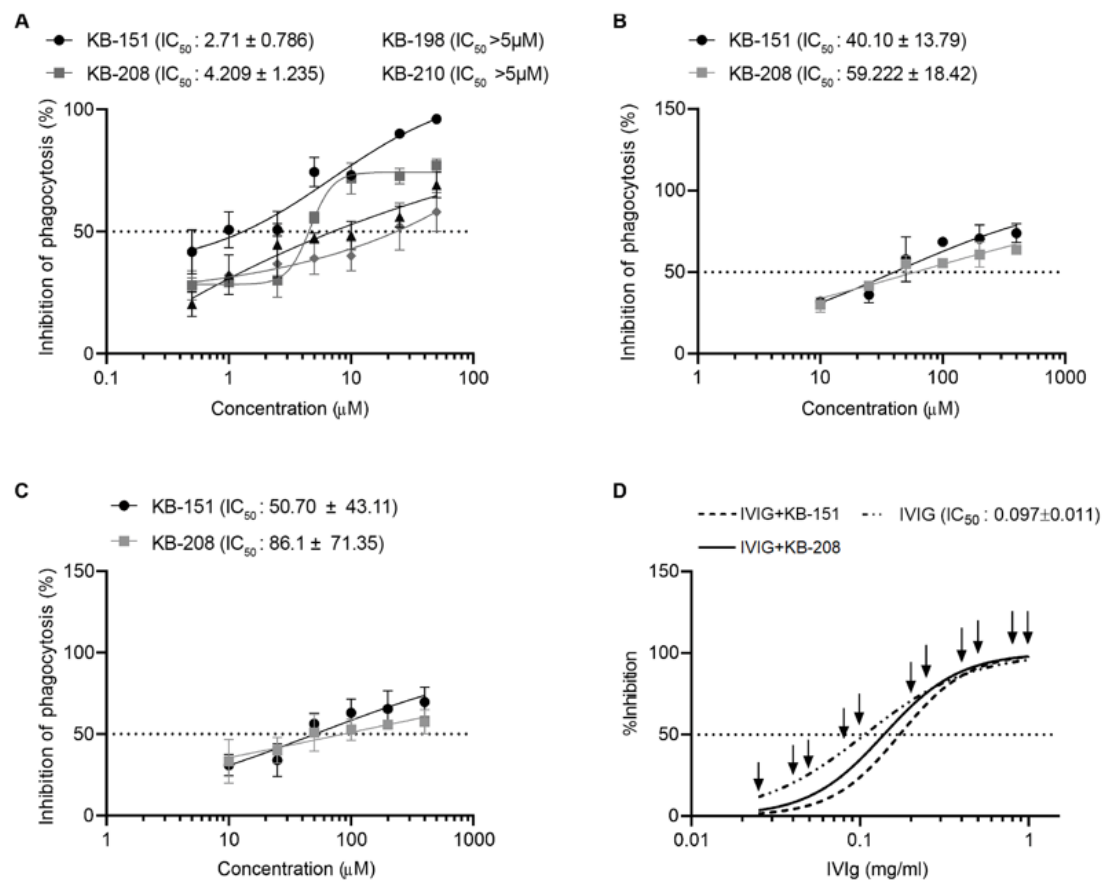
Figure 5. ( A ) Human PBMC’s IC 50 s for the top four compounds. ( B ) Mouse PBMC’s IC 50 s for the two lead compounds. ( C ) Mouse macrophages, RAW 264.7′s, IC 50 s for the two lead compounds. ( D ) Dose-inhibitory response of IVIG alone (IC 50 = 0.097 ± 0.011) or with addition of KB-208 (___) or KB-151 (—-) at their IC 50 (hPBMCs) concentrations (4 µ M and 3 µ M, respectively). Lead compounds are administered along with IVIG at each IVIG concentration used in its titration (arrows). Bars represent mean ± SD, and N = 3.